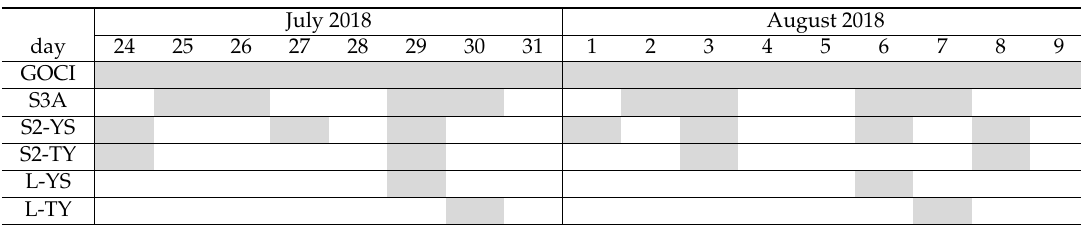
Table 3 lists satellite images of the SSK available during the red tide bloom event in 2018 (from 24 July to 9 August). GOCI images were acquired eight times per day. Sentinel-3 OLCI images were not obtained on a regular schedule, and were instead acquired at intervals of 1–3 days.